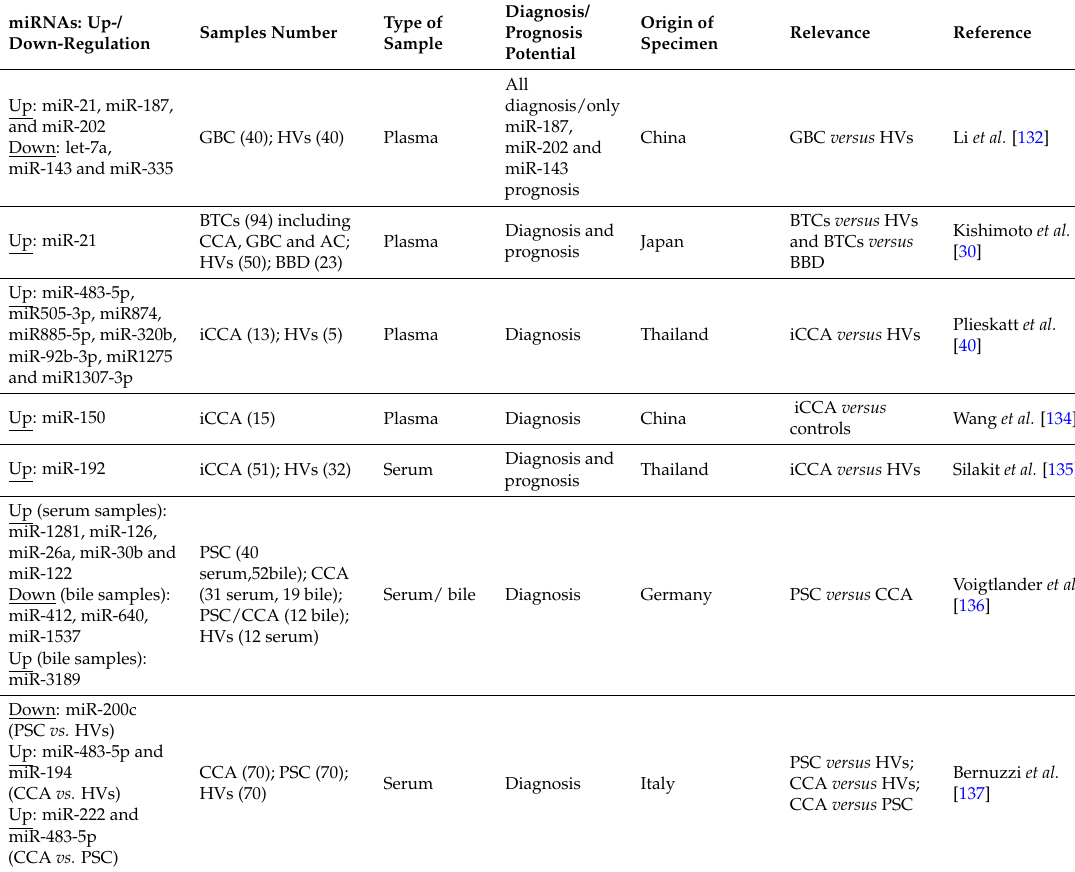
Table 2. Circulating miRNAs with potential to become markers in biliary tract